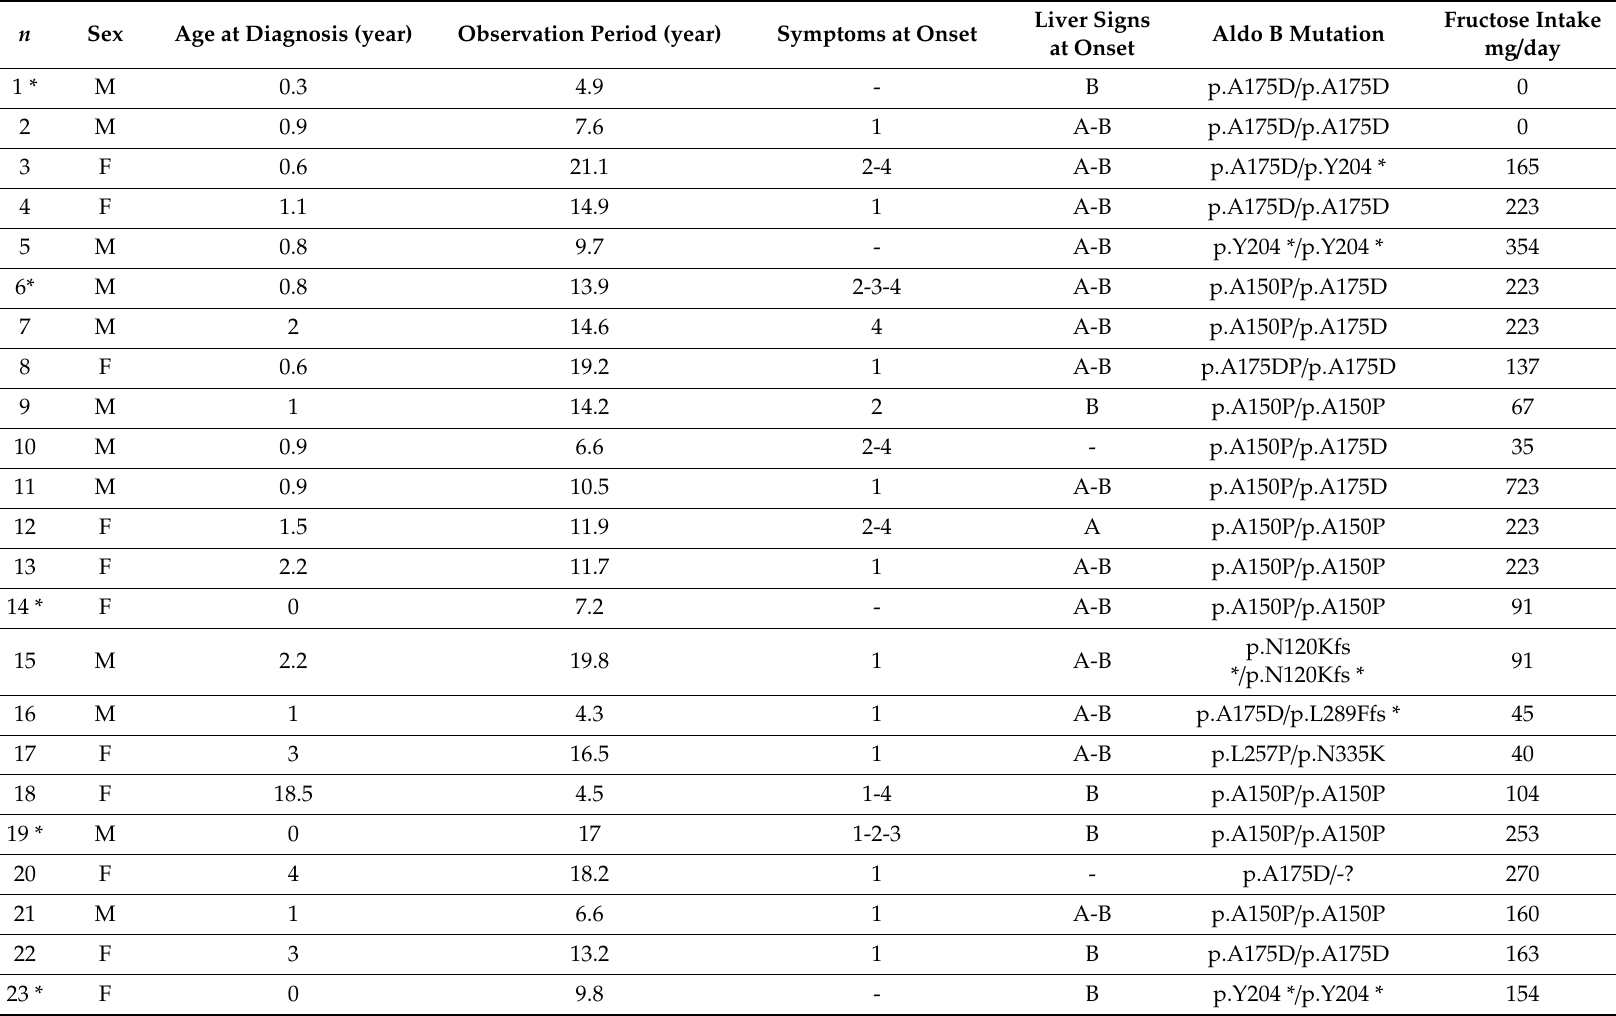
Table 1. Principal features of 48 hereditary fructose intolerance (HFI) patients and their daily fructose